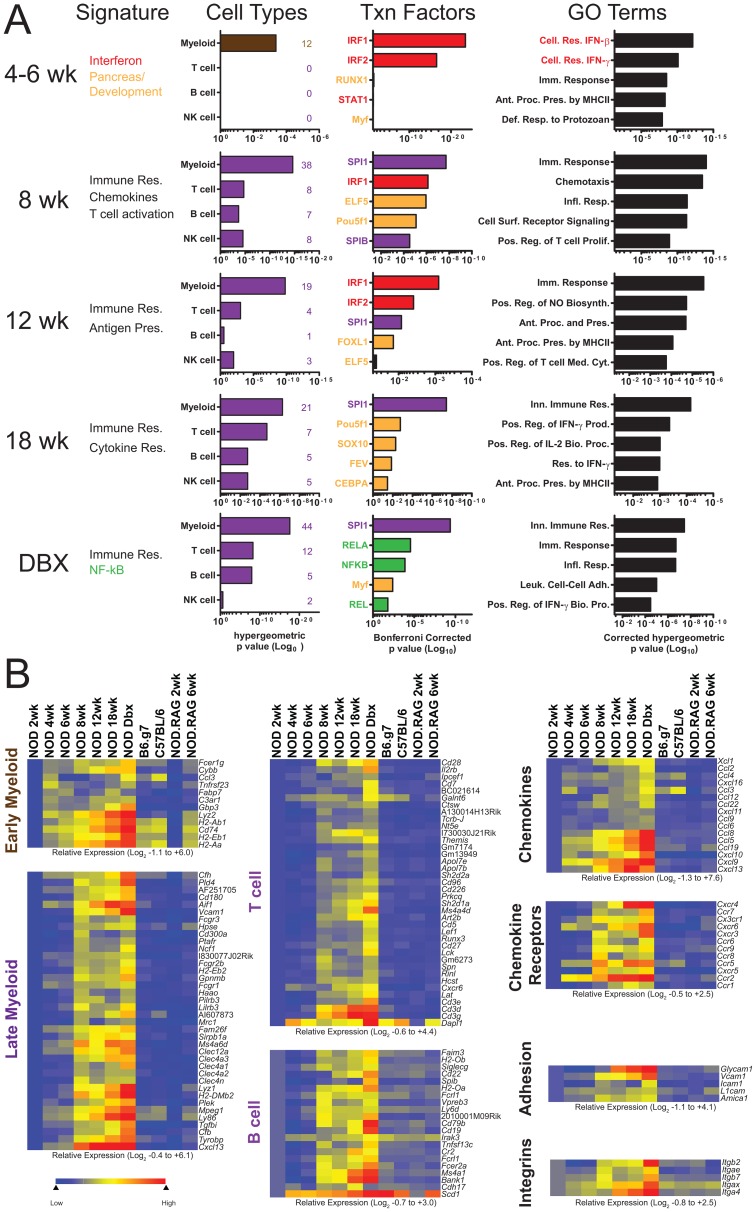
Analysis of inflammatory genes changes throughout diabetogenesis.Differentially expressed genes identified in Figure 3 and Supplemental Table 1 were interrogated for transcriptional regulation signatures and gene ontology (A) or for their immunological role (B). (A) Cell enrichment, transcription factor binding, and gene ontology analysis were performed. Numbers in parentheses indicate the number of cell type specific genes identified as statistically significantly changed at the given age. (B) Hierarchically clustered heat maps of cell type specific gene changes throughout diabetes. Values were adjusted to a per row color scale so all changes were relative to 2 wk NOD mice.